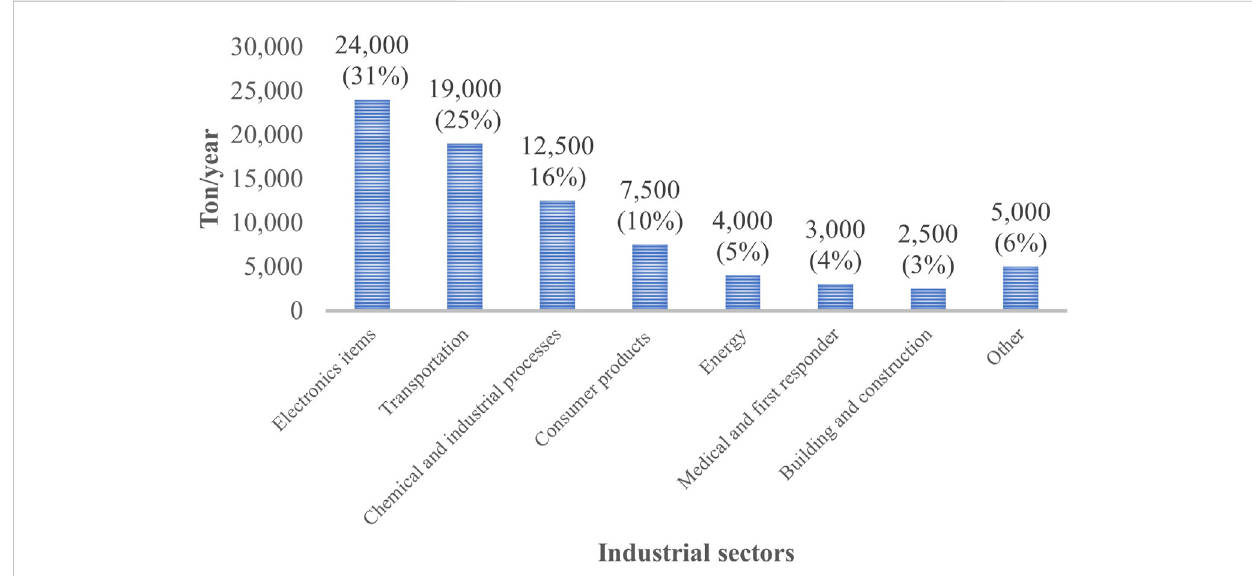
FIGURE 5 Use of fl uoropolymers (in tons) by United States industrial sectors in 2018 (Kempisty and Racz,